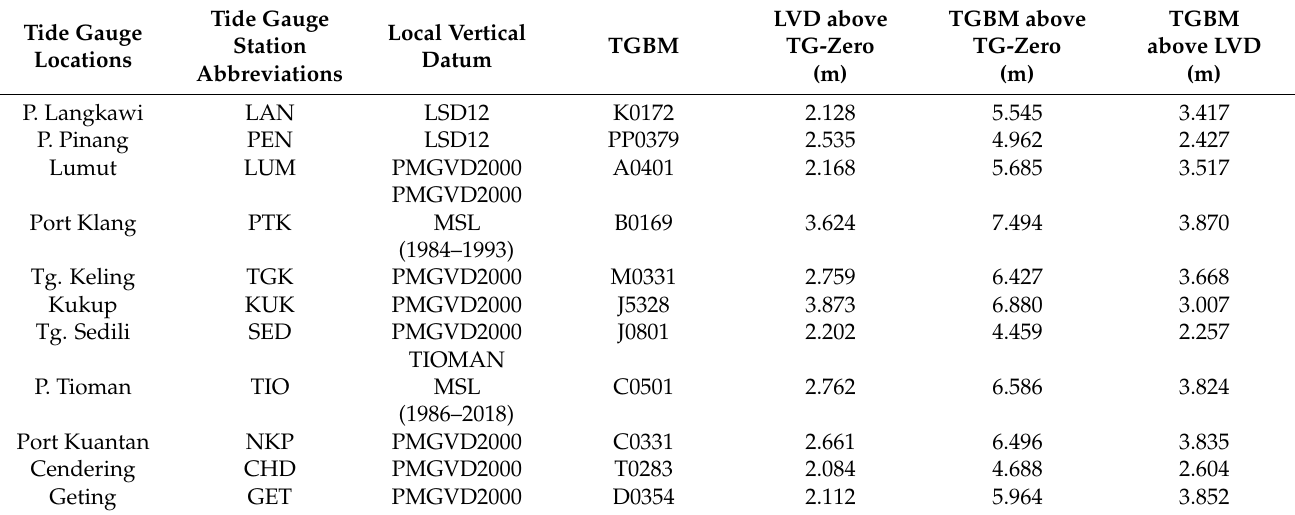
Table 1. Local vertical datums (LVD): LSD12, Tioman, and PMGVD2000 (Port